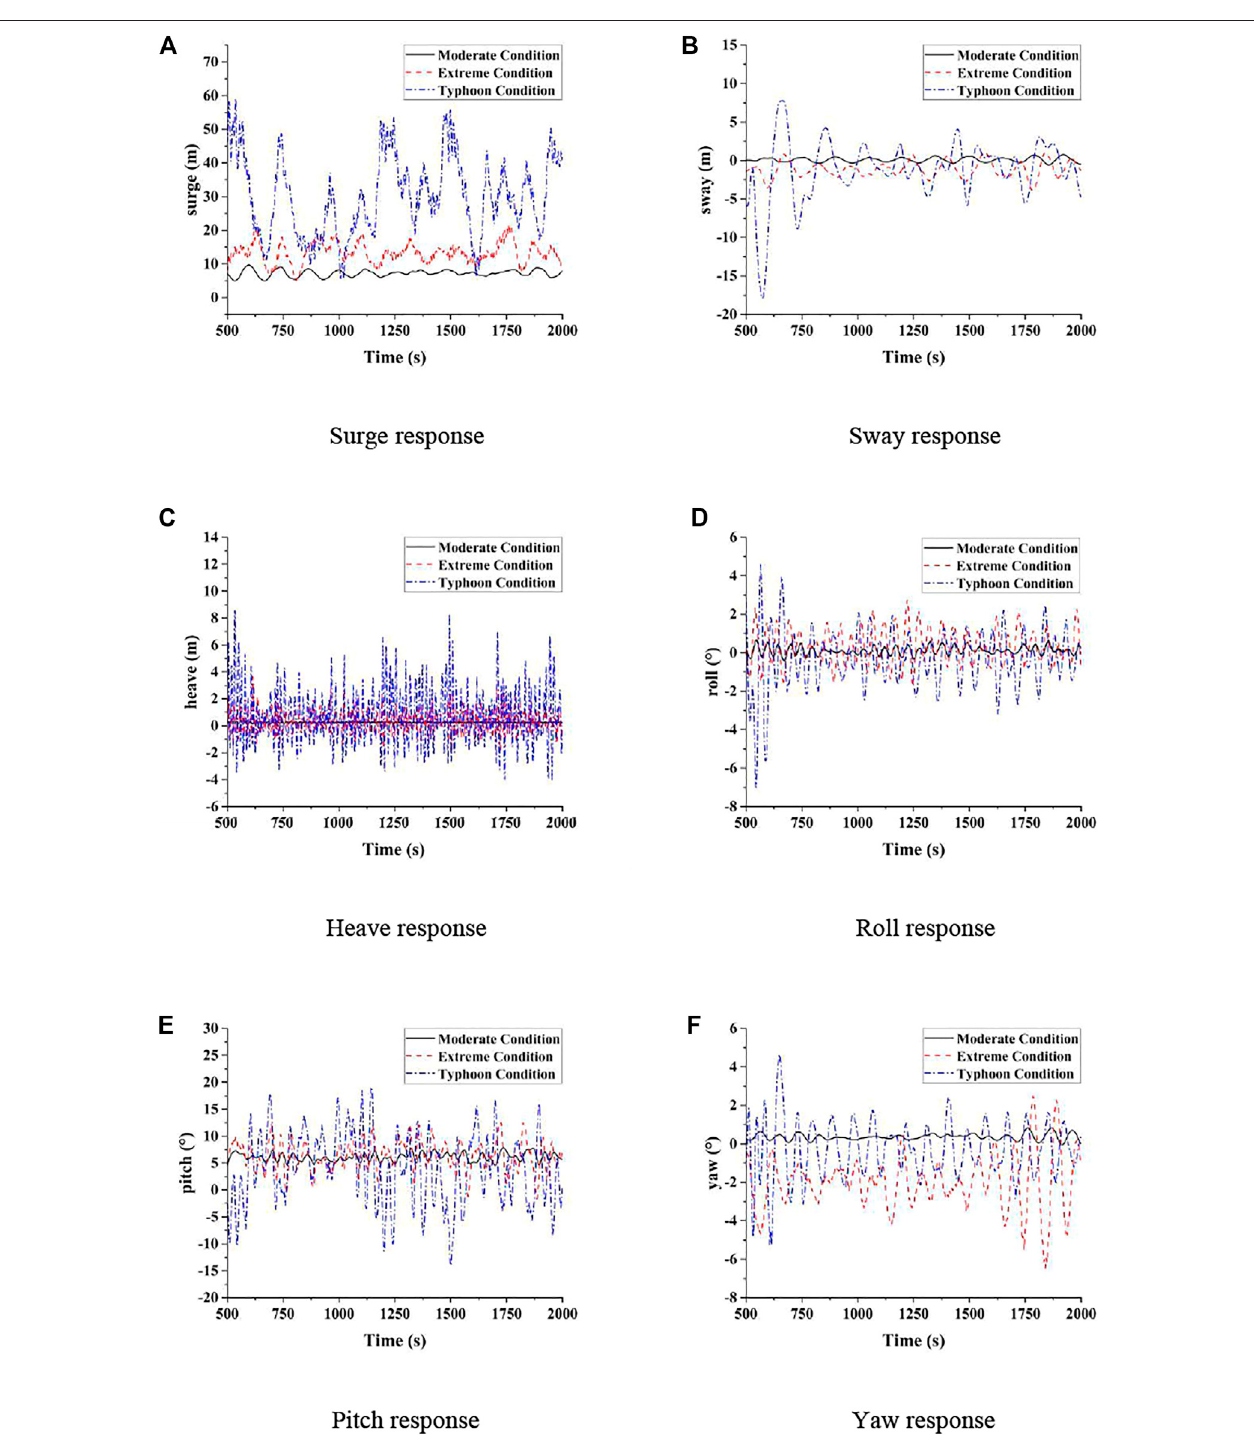
FIGURE 10 | Motion responses of the 15 MW FOWT under three different sea states. (A) Surge response. (B) Sway response. (C) Heave response. (D) Roll response. (E) Pitch response. (F) Yaw response.